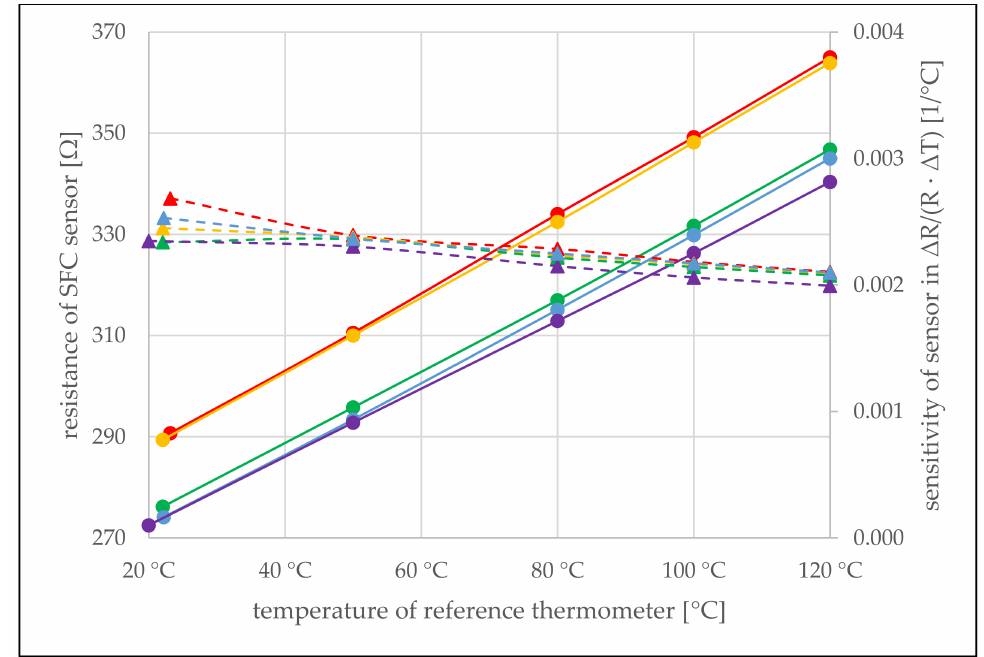
Figure 4. Linear temperature response of five different SFC sensors (the measuring points are indicated by circles) after release from the glass substrate and heating to 130 ◦ C (burn-in). Practically identical sensitivities of about 0.002 1/ ◦ C are obtained (the values calculated from the measuring points are indicated by triangles connected by dashed